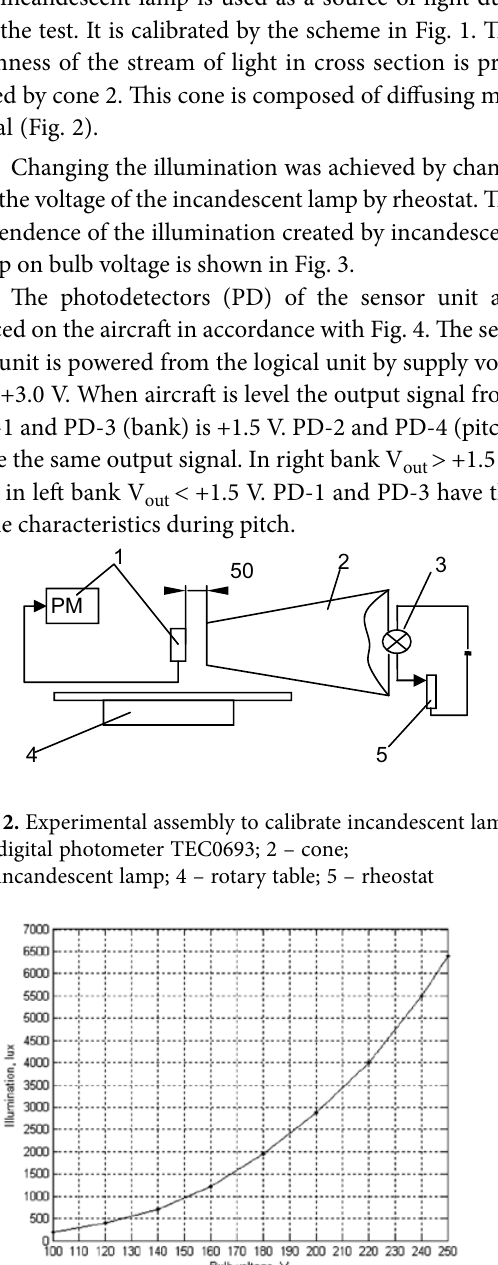
Fig. 3. Illumination created by incandescent lamp